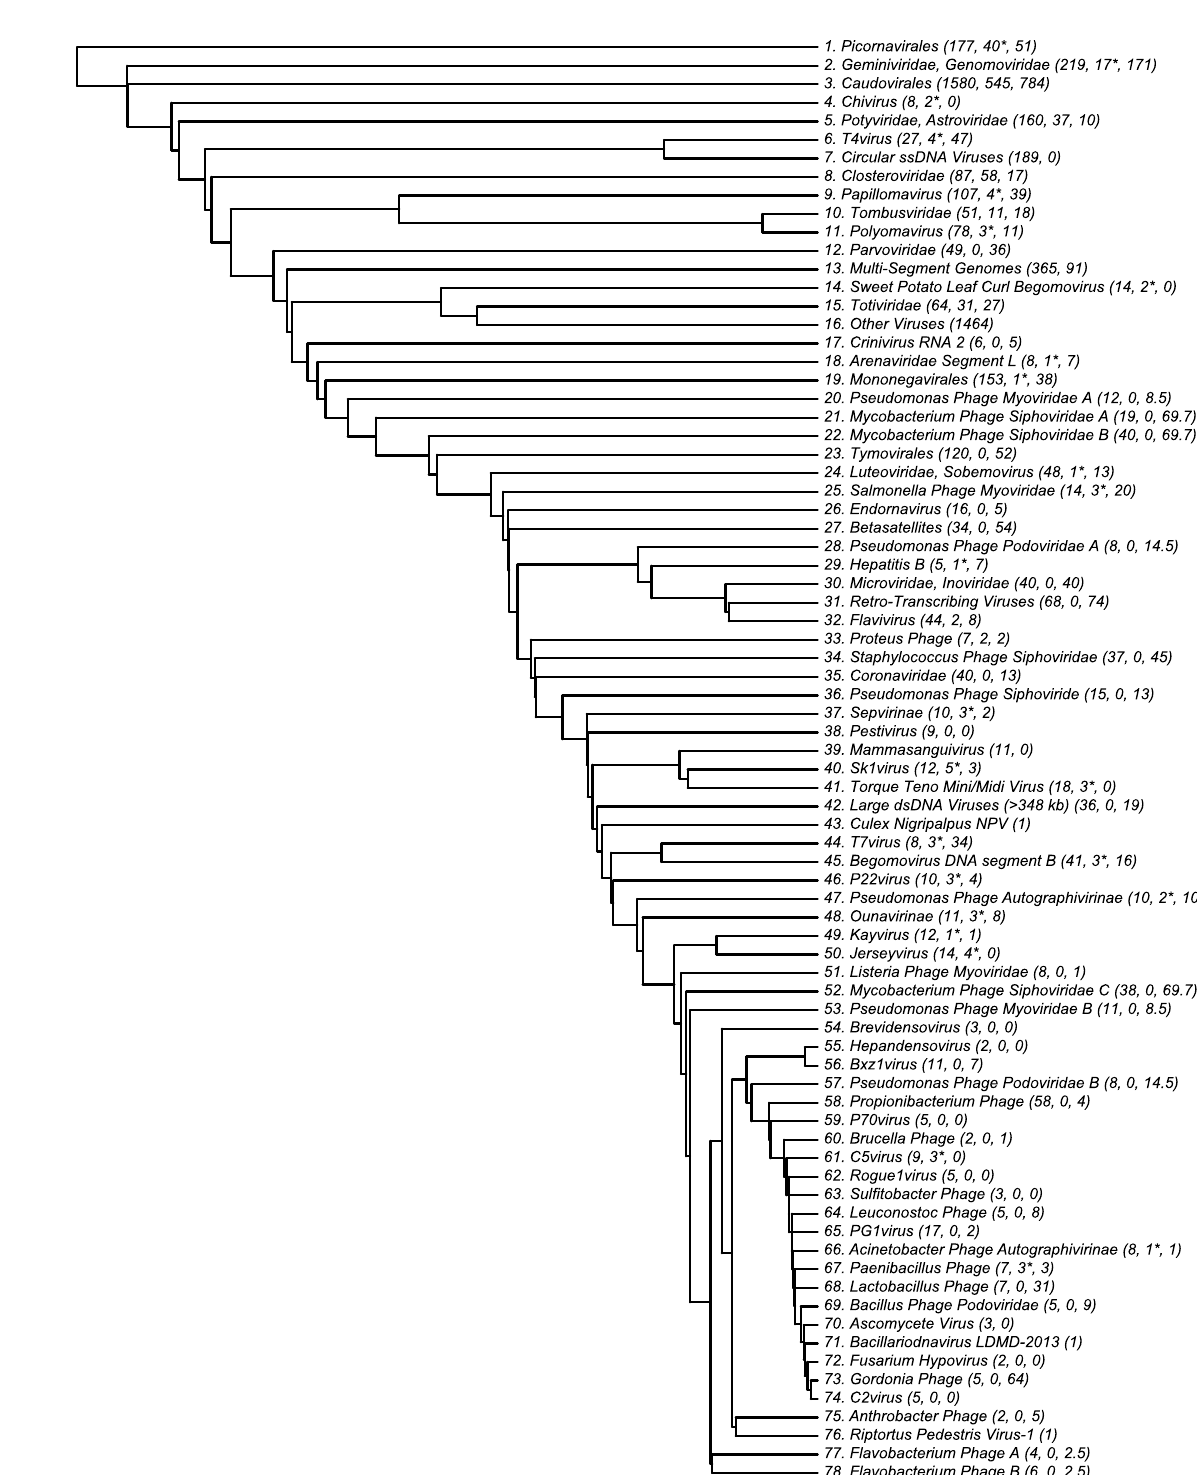
PLOS ONE | https://doi.org/10.1371/journal.pone.0220440 August 14,